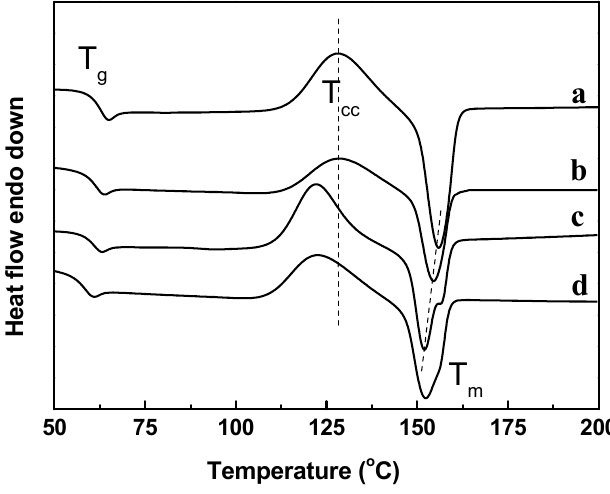
Figure 4. The second heating DSC curves of PLA and PLA/PBAT blends: